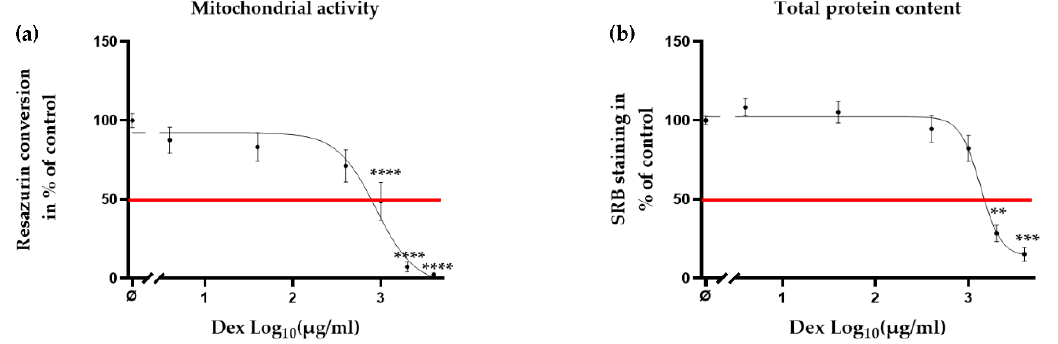
Figure 3. CSE exposure induced cell death by increasing ROS production. Cells ( N ≥ 3, n ≥ 3) were cultured in a medium containing 0%, 1%, 5%, and 10% CSE or 0.01% H 2 O 2 . ( a ) Dichlorfluorescein- diacetate (DCFH-DA) assay was used to evaluate reactive oxygen species (ROS) production in primary human chondrocytes exposed to CSE, and 0.01% v / v H 2 O 2 was used as a positive control. ( b ) Calcein-AM (green) and Ethidium homodimer (red) were administered to show living and dead cells on day 3, respectively, and 0.01% v / v H 2 O 2 was used as a positive control. Results are given as fold of control (untreated group, represented in red line) and presented as mean ± SEM. ** p < 0.01, **** p < 0.0001 as compared to control group.